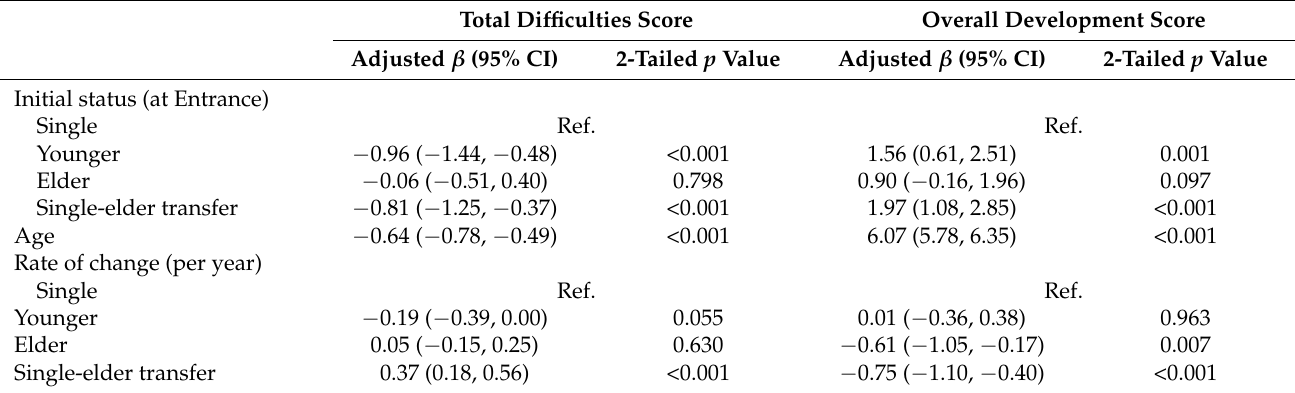
Table 2. Association between birth order and early childhood development. Total Difficulties Score Overall Development